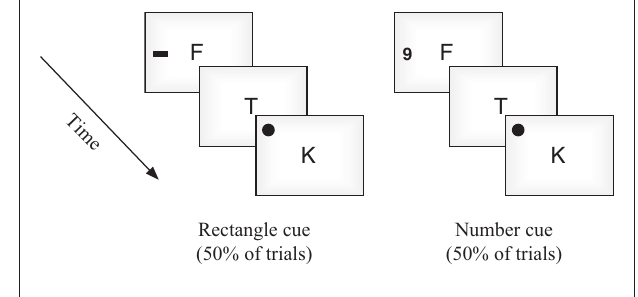
FIGURE 2 | The two different cue types used in the task in Experiment